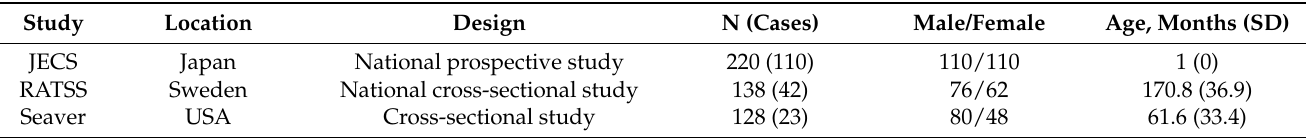
Table 1. Participant